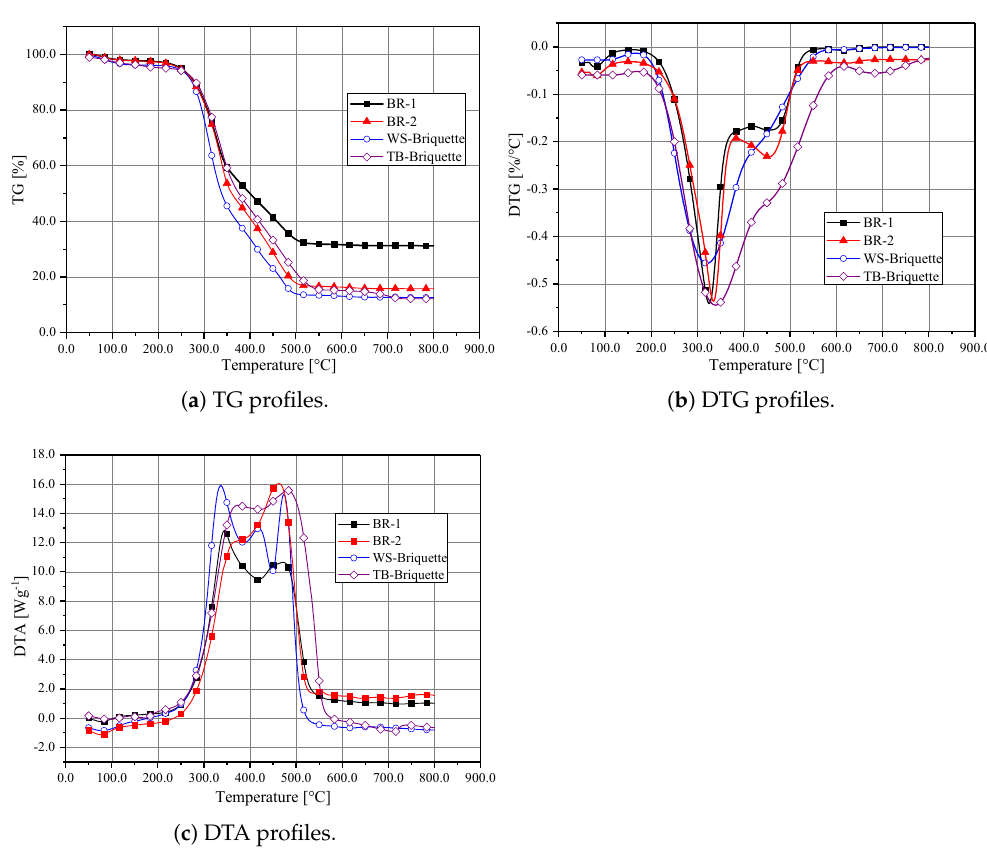
Figure 6. Thermogravimetric (TG), Differential Thermogravimetric (DTG) and Differential Thermal Analysis (DTA) profiles for biomass briquettes. Table 2. Combustion characteristics parameters of biomass